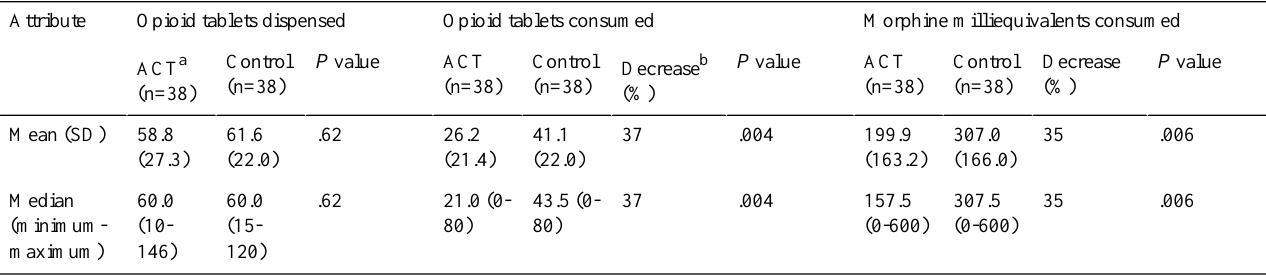
Table 5. Opioid pain medication utilization by group during the 2-week study period.